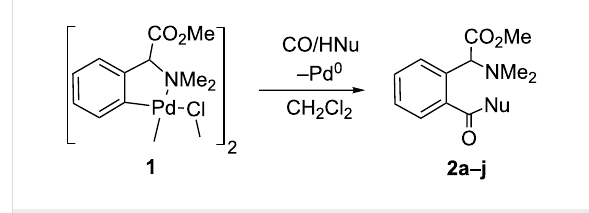
Scheme 3: Carbonylation of 1 to afford glutamate and glutamine derivatives 2a – j